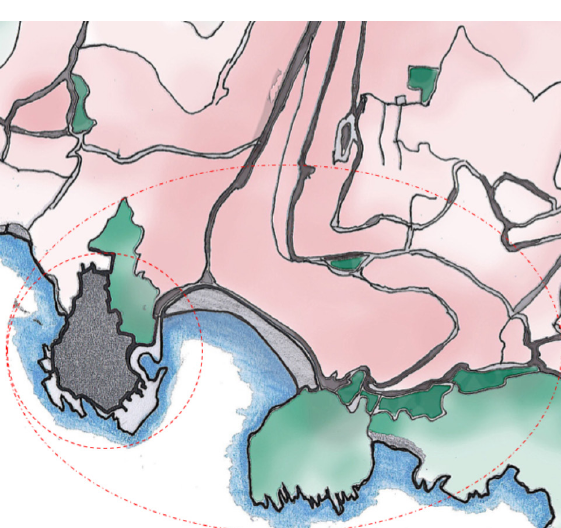
Fig. 2. Urban structure of the city of Ulcinj, focus on the City